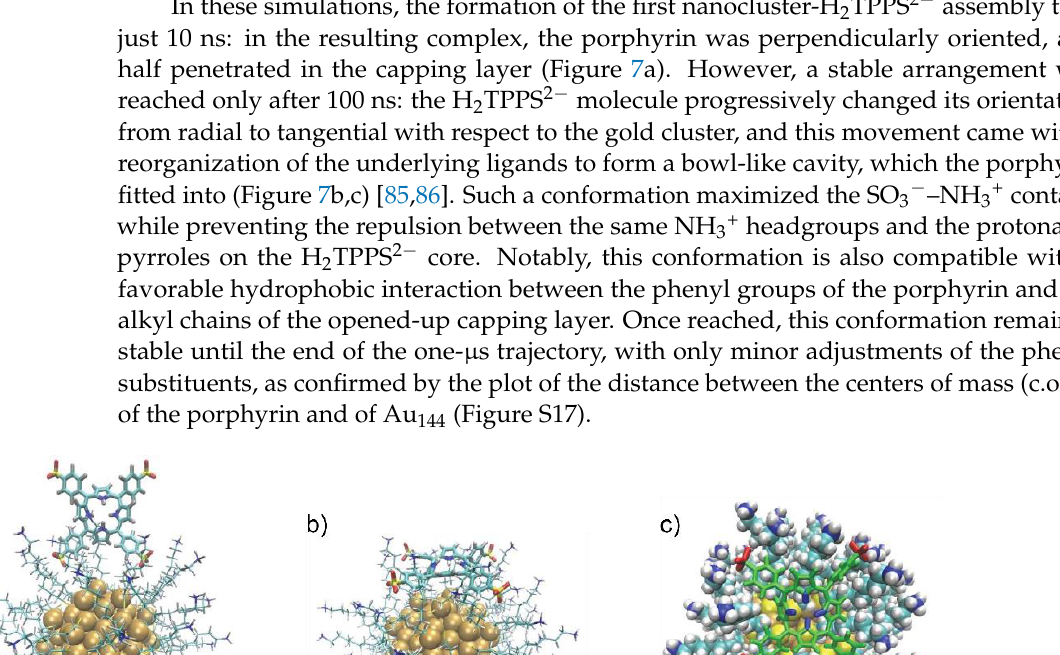
Figure 8. The nanocluster-dimer supramolecular assembly after 1 μ s MD. The two porphyrin resi- dues are both radially oriented with respect to the Au 144 L 60 cluster. 4. Discussion Overall, the results reported here reveal that the interaction of cationic gold nanopar- ticles with the tetra − 4-sulfonyl-phenyl-porphyrin TPPS produces a series of different structures depending on the dye/nanoparticle ratio, the pH, and the particle size. These conformations are graphically summarized in Figure 9.